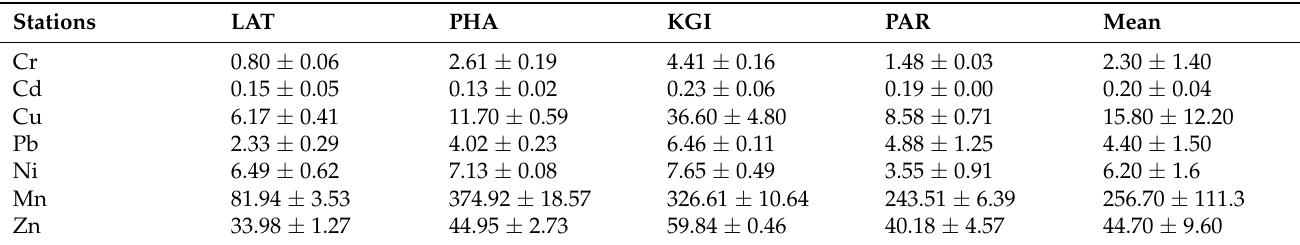
Table A5. Concentrations of Cr, Cd, Cu, Pb, Ni, Mn, and Zn (mg/kg ± S.D. in dry weight) (n = 3) in the leaves of the species Colobanthus quitensis collected at the LAT, PHA, KGI, and PAR stations with the mean concentrations of each metal.